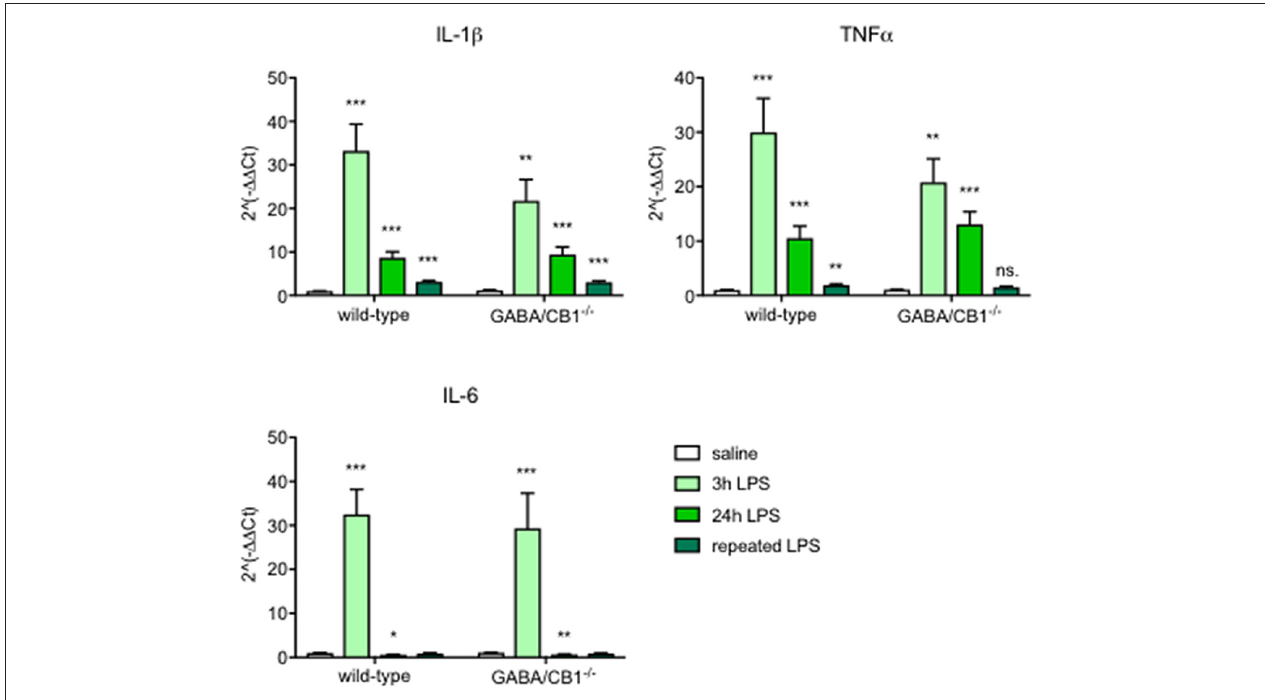
FIGURE 1 | Expression of inflammatory cytokines in the brain of wild-type (WT) and GABA/CB1 − / − mice; control groups are pulled together and shown as white bars ( n = 21), 3 h after an intraperitoneal lipopolysaccharide (LPS)-treatment ( n = 7) shown as light green bars, 24 h after an intraperitoneal LPS-treatment ( n = 7–8) shown as intensive green bars and 24 h after the fourth daily intraperitoneal LPS injection ( n = 6) shown as dark green bars. ns. stands for not significant; ∗ p < 0.05; ∗∗ p < 0.01; ∗∗∗ p < 0.001 difference detected by Bonferroni’s t -test between LPS and saline-treated mice from the respective control